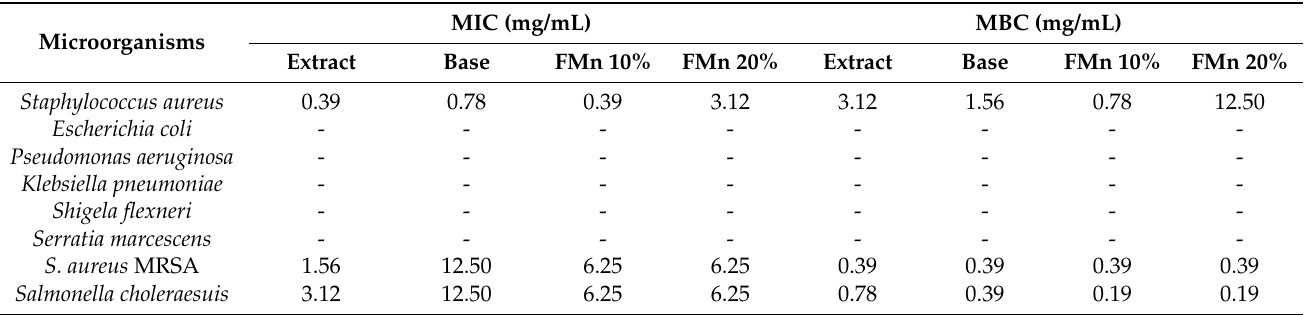
Table 2. Mean values of the antimicrobial activity of crude hydroalcoholic extract of Morus nigra L. in the base emulsion and in emulsions containing the extract. n = 3.